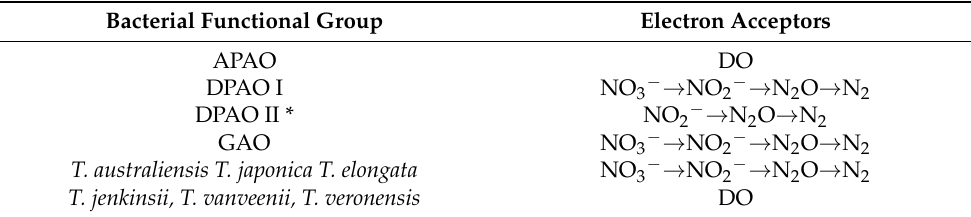
Table 1. Summary of preferable electron acceptors by the main functional bacterial groups involved in